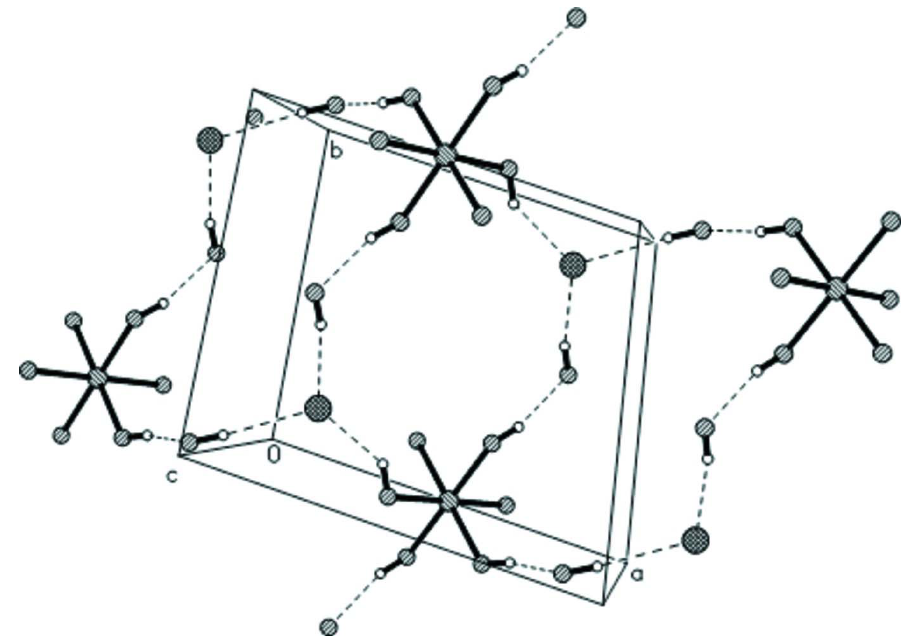
Figure 3 Hydrogen bonding [dashed lines] in part of the crystal structure between the [Cu(H water